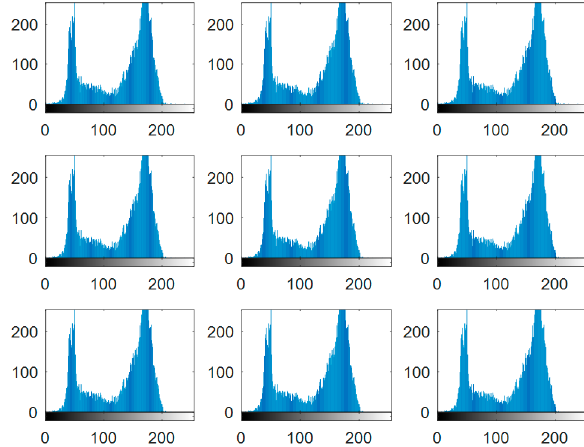
Figure 7. Histogram distributions of the sample facial images in Figure 5.